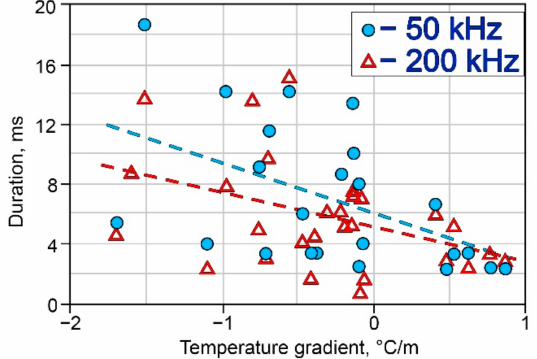
Figure 6. Echo duration vs. temperature gradient in upper 1 m of bottom sediments, 50 kHz (bold blue circle) and 200 kHz (open red triangles). Dotted lines show linear